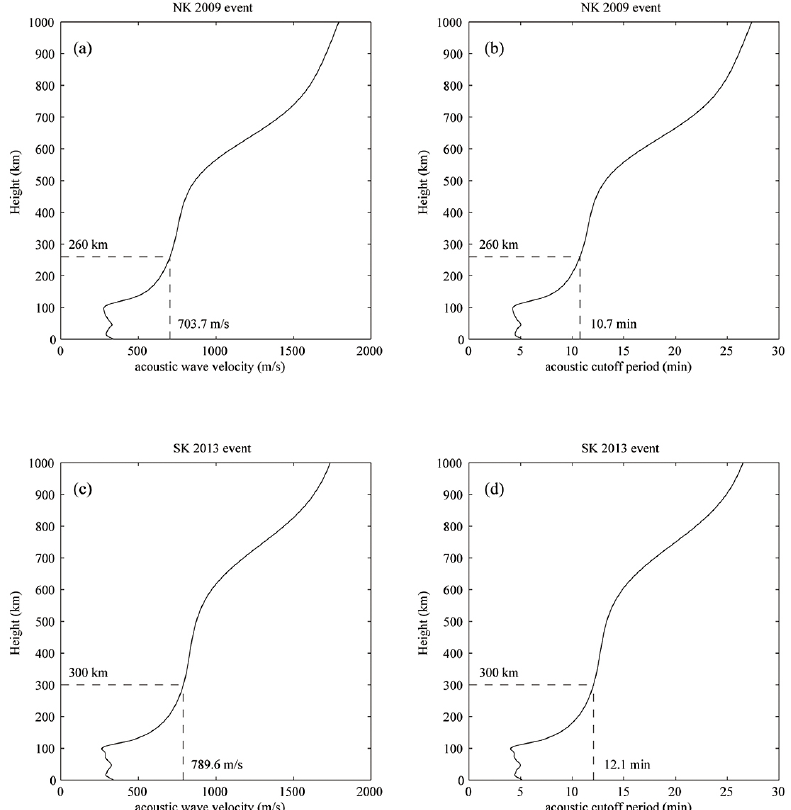
Figure 2. Estimation of averaged acoustic velocities and cutoff periods using NRLMSISE-00 model at rectangular boxes shown in Fig. 1 for the 2009 North Korean rocket launch (a and b) and for the 2013 South Korean rocket launch (c and d)